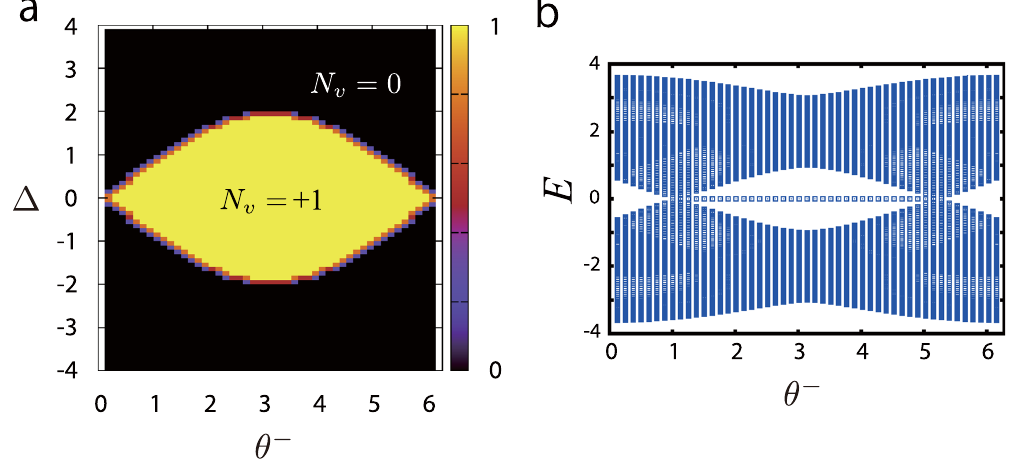
Figure 6. ( a ) Phase diagram of the existence of the zero-energy edge state for θ a = θ b ± π = 0 and θ + = 0. θ − and Δ are free parameters. ( b ) Energy spectra for Δ =